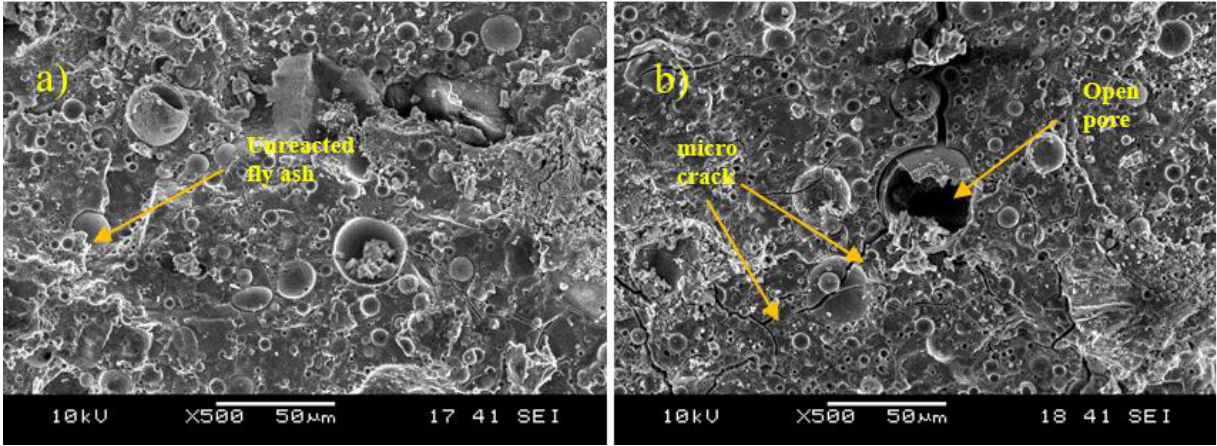
Figure 6. Fly ash/dolomite morphology for ( a ) 8 M and ( b ) 14 M NaOH